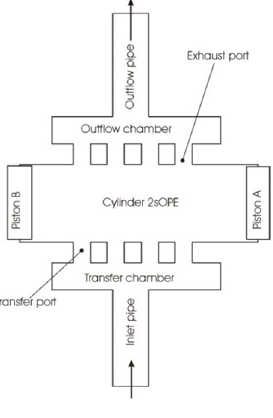
Fig. 7. Calculation model of 2sOPE Based on the presented mathematical model, geometric data of the engine and assumption of adiabatic processes for perfect gas, thermodynamic parameters of the Atkinson cycle were determined. Calculations were done in the com- puter program worked out by the author, which enables achieving many other engine parameters. Pressure, temper- ature and volumes for the points shown in Fig. 6 are pre- sented in Table 2. The minus delay of exhaust port close denotes earlier opening and closing of the exhaust ports in comparison to the symmetric phases. The presented results were obtained at assumption of initial pressure at point 0 and 1 equal 1.013 bar and temperature 293 K (without